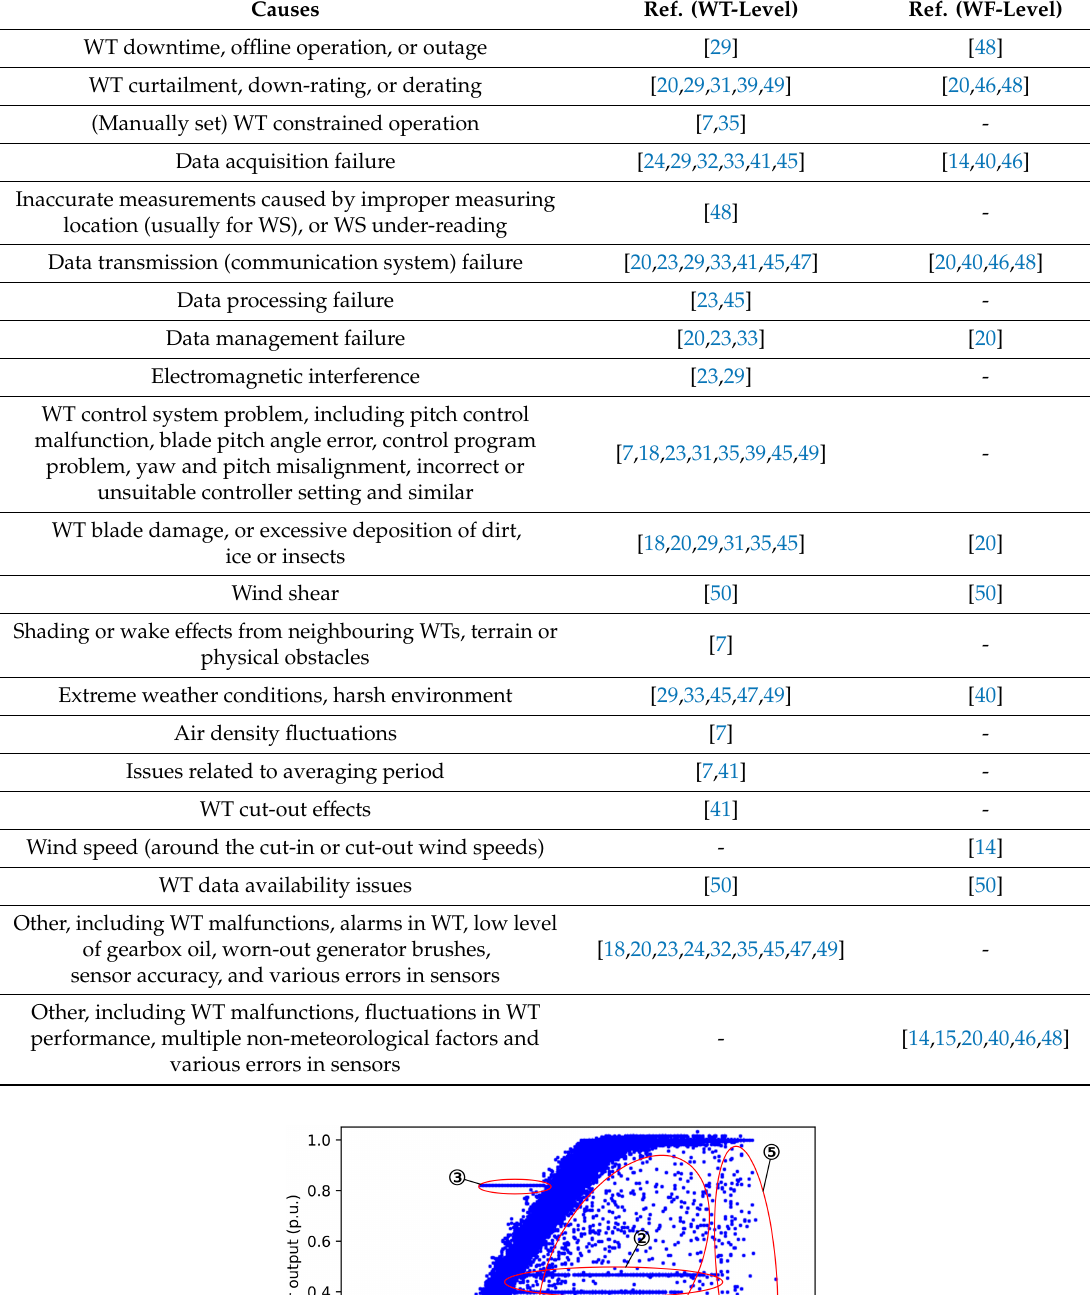
Table 2. Summary of common causes of outliers in WT and WF measurements. Causes